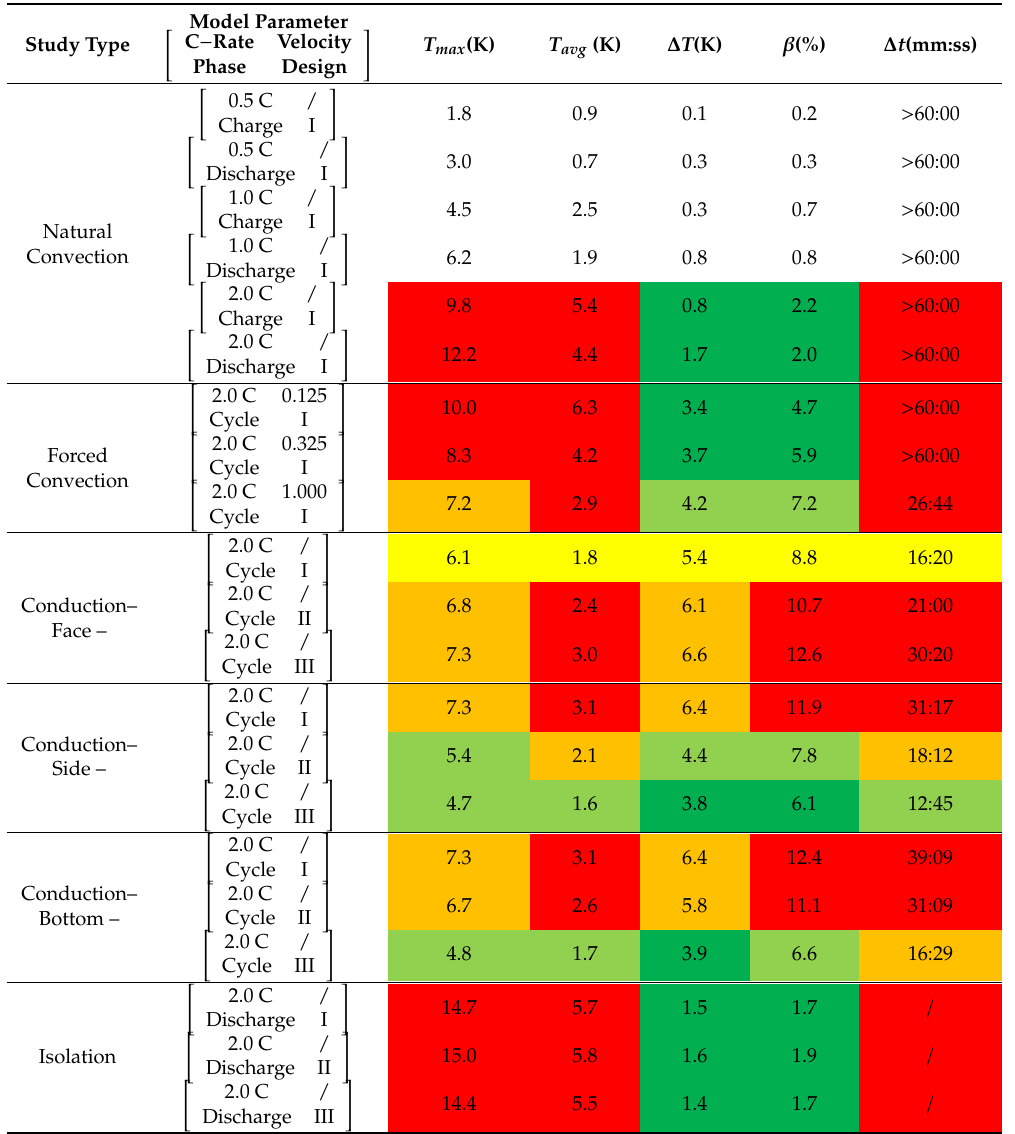
Table 3. Quantities of interest of the model studies.